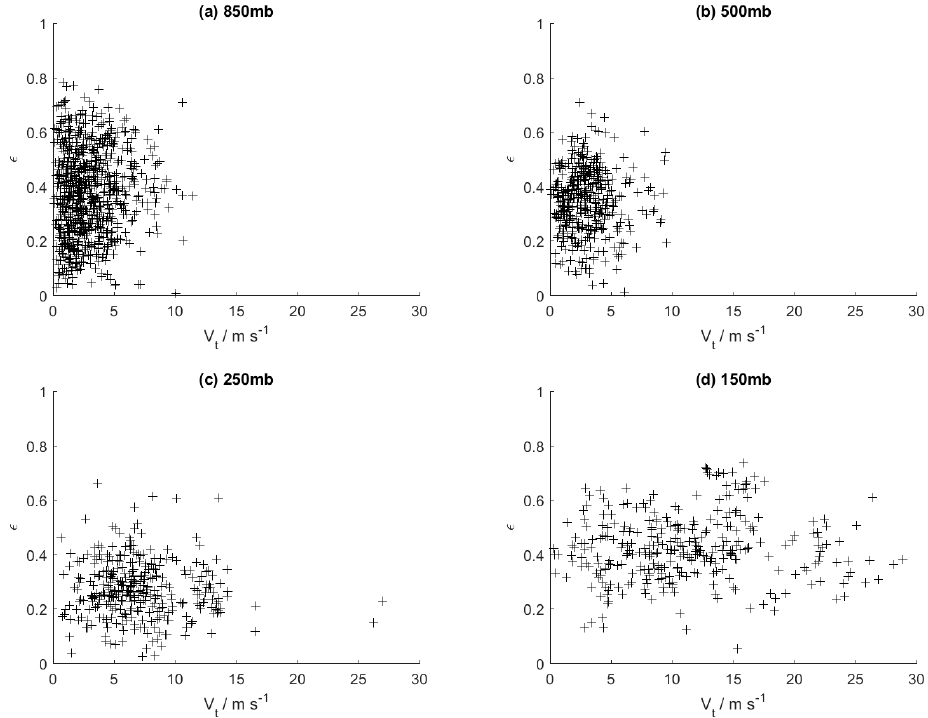
Figure 4. Scatters of ε vs. V t for four of the eleven standard pressure levels: ( a ) 850 mb; ( b ) 500 mb; ( c ) 250 mb; ( d ) 150 mb.